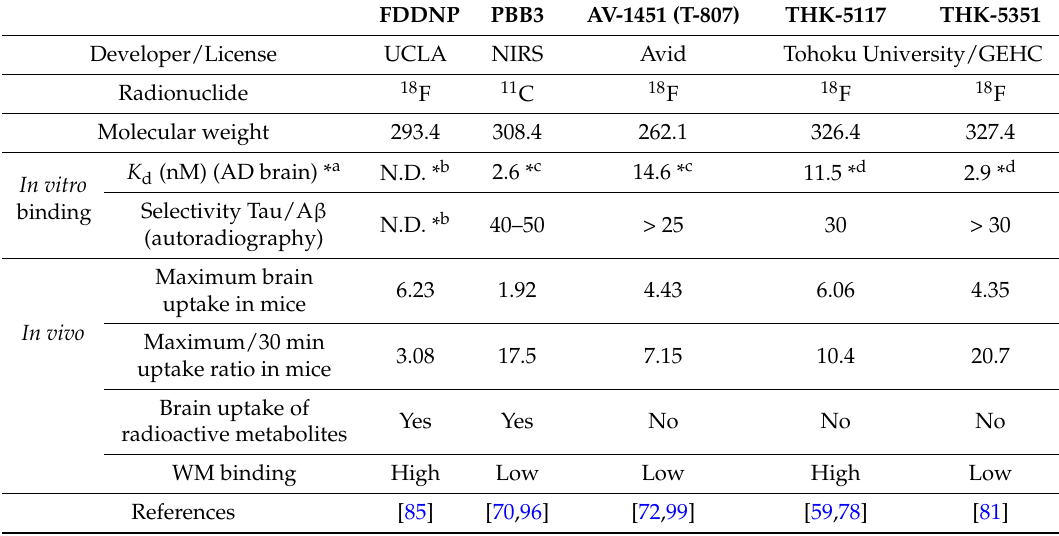
Table 1. In vitro binding and in vivo characteristics of reported tau PET radiotracers.